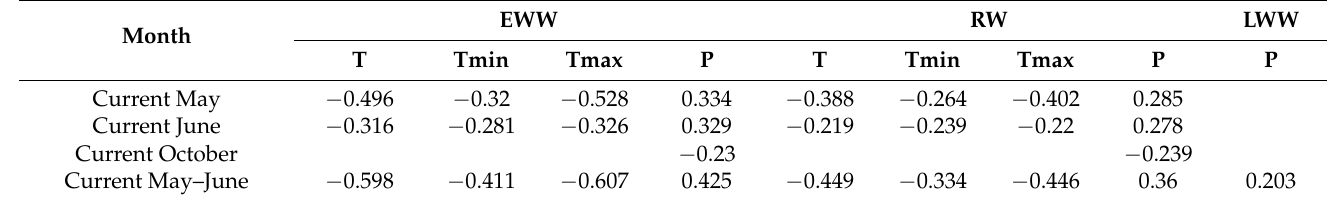
P of the Tongbai meteorological station ( p <